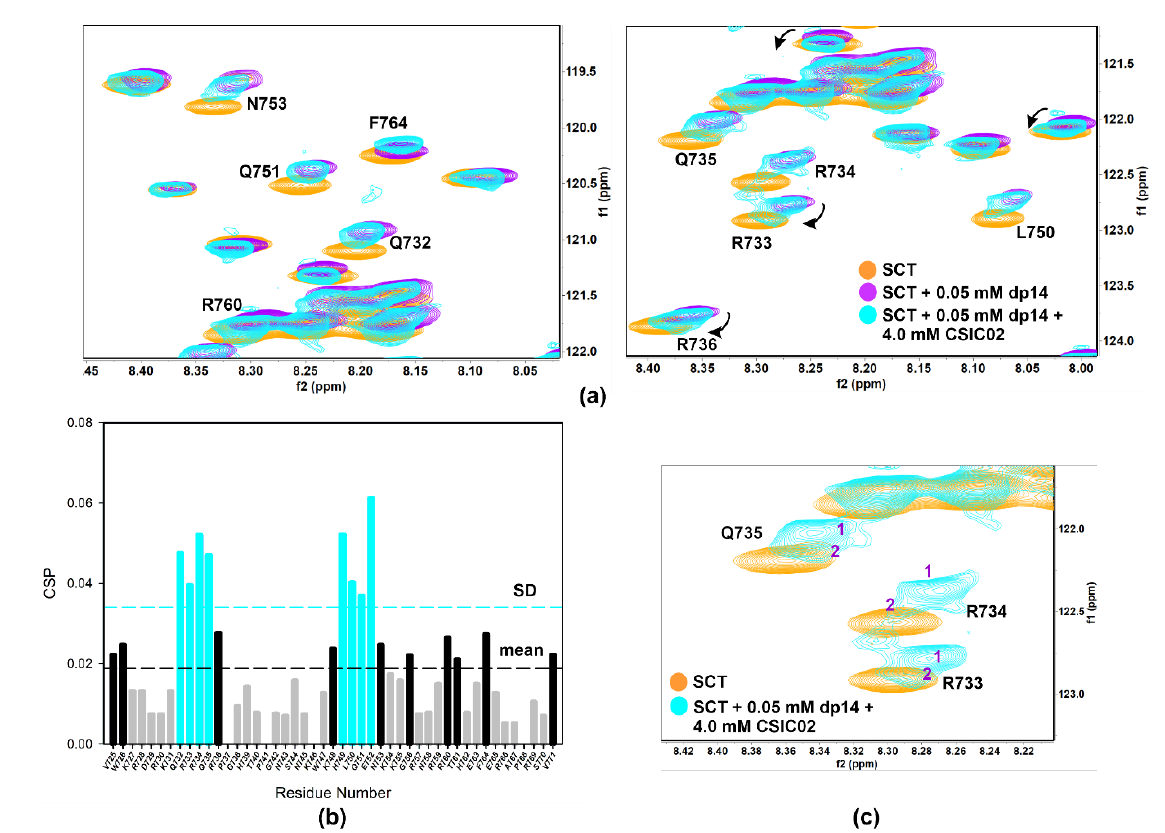
Figure 8. ( a ) Overlay of [ 1 H- 15 N]-HSQC spectra of 0.2 mM Sema3A C-terminal region (orange) highlighting the changes of 0.05 mM (or 0.35 mM in disaccharide units) dp14 heparin oligosaccharide binding in the absence (purple) and the presence (turquoise) of 4 mM CSIC02. ( b ) Weighted chemical shift perturbation (CSP) of C-terminal Sema3A region in presence of both dp14 heparin and CSIC02. The absolute values of the chemical shift differences between the presence and absence of dp14 are plotted in ppm and calculated comparing with the chemical shifts of the protein alone. ( c ) Overlay of [ 1 H- 15 N]- HSQC spectra of 0.2 mM Sema3A C-terminal region in the absence (orange) and the presence of both 0.05 mM dp14 and 4 mM CSIC02 (turquoise). We observed two species in slow exchange for some peaks (R733, R734, and Q735 in the GAG binding region). Spectra were acquired in 10 mM acetate, 150 mM NaCl, pH 4.5, 10% D 2 O.